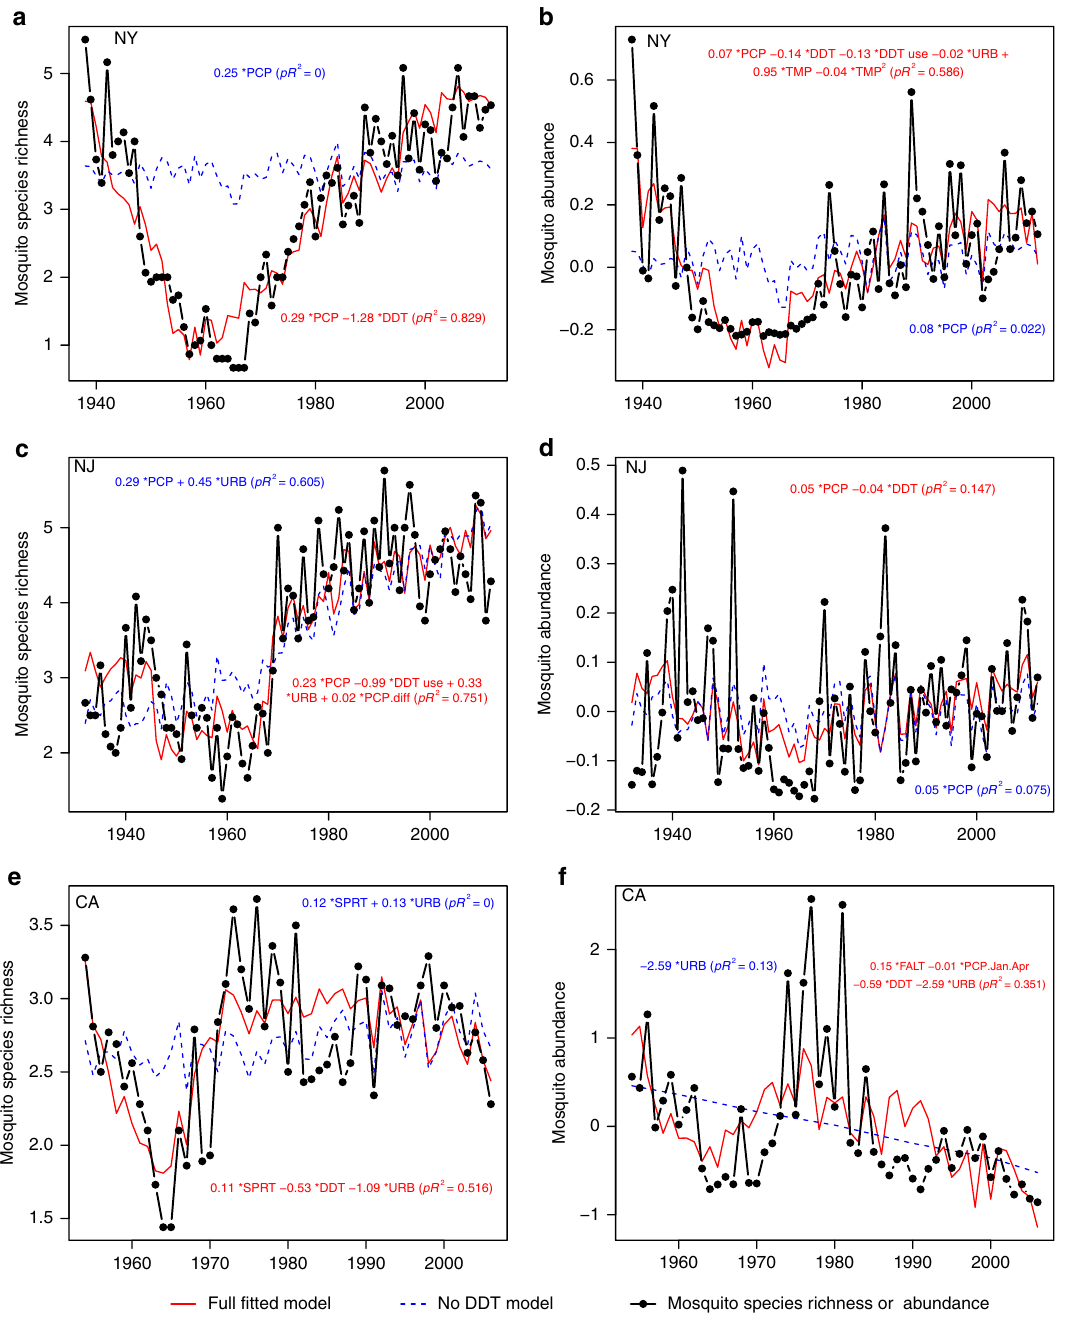
Figure 2 | Fitted models and observed data of mosquito species richness and abundance. Left panels and left axis show mosquito species richness, expressed as the average number of species collected per trap per night from New York (NY) ( a ), New Jersey (NJ) ( c ), and California (CA) ( e ). Right panels show mosquito relative abundance per trap night expressed as Z -scores from New York (NY) ( b ), New Jersey (NJ) ( d ), and California (CA) ( f ). The equations in each panel give the fitted regression model with all significant predictors ( P o 0.05) and fraction of variance explained pseudo- R 2 ( pR 2 ) from the generalized least squares models. Full model is shown in red, whereas the reduced model excluding DDT parameters is shown in blue (dashed line). The abbreviations designate DDT concentration (DDT, Z -scores), DDT use by the mosquito control districts (DDT use, yes/no), precipitation (PCP, standardized precipitation index), total precipitation in January through April (PCP.Jan.Apr), precipitation difference [April þ March] (cid:2) [January þ February] (PCP.diff), urbanization (URB, human population in 100,000), spring (SPRT) and fall (FALT) temperatures. For relative importance of the variables in the model see Table